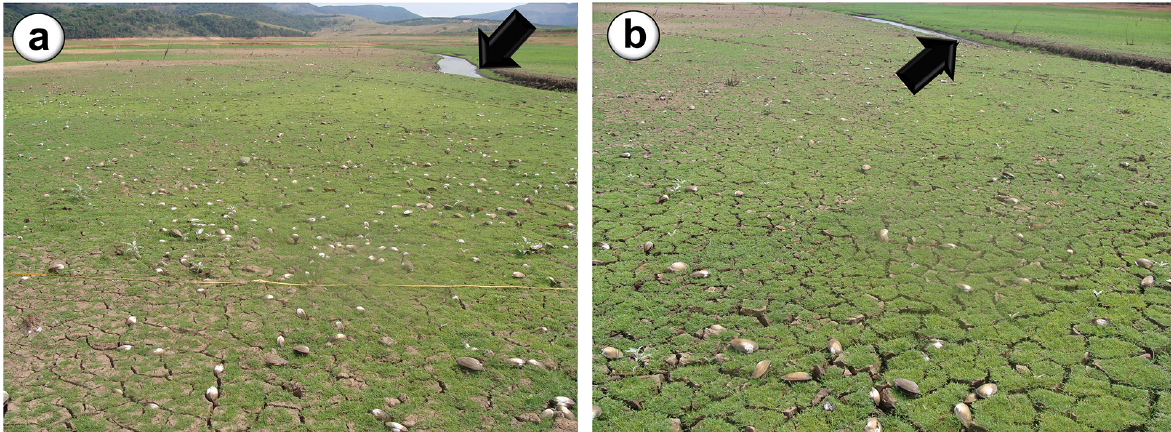
Figure 4. a-b. Massive mortality of Anodontites trapesialis with great accumulation of dead shells at Furnas HPS reservoir. Black arrows indicate the channel where living specimens were collected. Note the dry cracked soil during